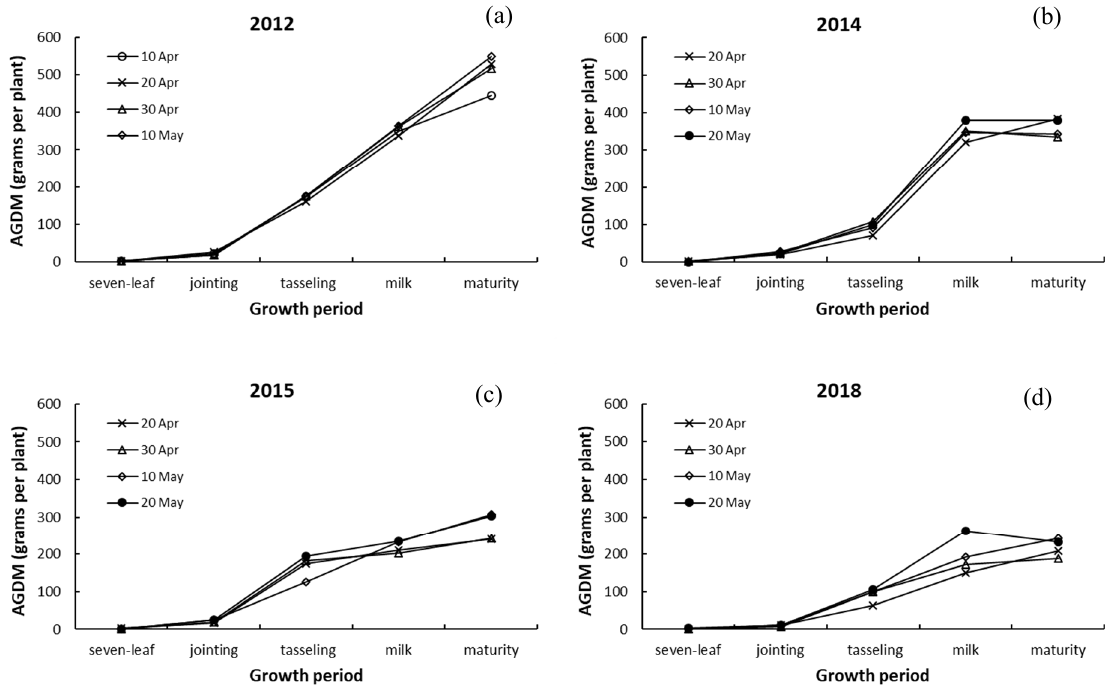
Figure 4. AGDMs of maize at different stages of growth: ( a ) 2012, ( b ) 2014, ( c ) 2015, ( d ) 2018.